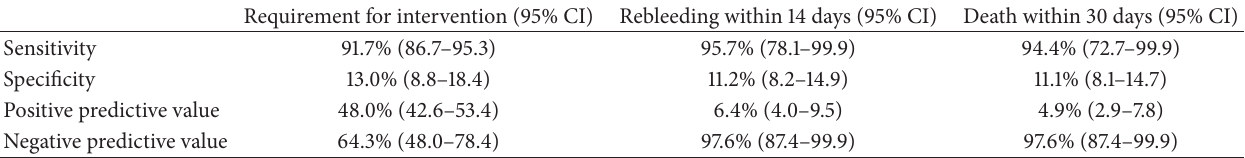
Table 3: Sensitivity and specificity of a preendoscopy Rockall score of zero.